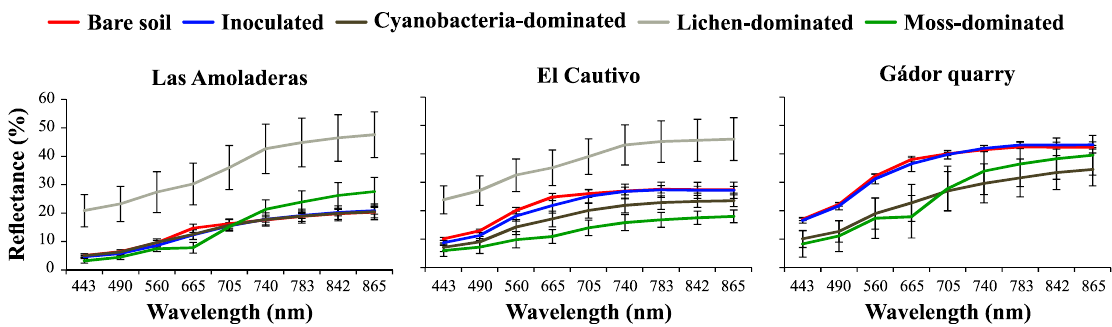
Figure 5. Sentinel-2 resampled reflectance for different biocrust types in Las Amoladeras, El Cautivo, and Gádor quarry study sites.